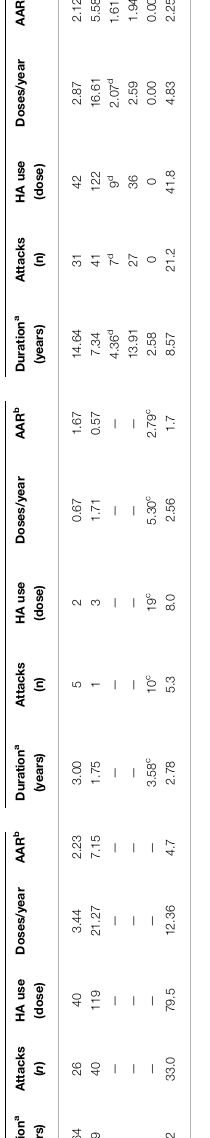
adverse events or infection occurred during the follow-up period ( Figure 2 ). Prophylaxis Discontinuation ( Case #3 ) Upon discontinuing HA prophylaxis to participate in a Phase 3 clinical trial for givosiran, this patient was subjected to a 4-week washout period and randomized double-blinded treatment (placebo) for 24 weeks according to the trial protocol (Balwani et al., 2020). During this time, the patient had 18 attacks requiring 30 HA doses ( Figure 1 ). Per trial protocol, an open-label treatment period succeeded the randomized treatment phase, and the patient received givosiran from Jan 16, 2019 to her most recent mid-2020 visit ( Figure 1 ). The clinical results of the trial open-label period are summarized in Figure 1 , Supplementary Table S5 . In short, 13 porphyric attacks occurred during the open-label period, and only 13 doses of HA were